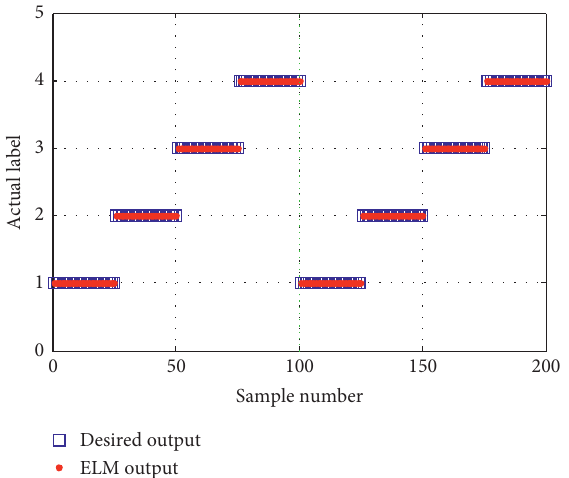
Figure 29: Classification results of the first trial of the proposed approach in case